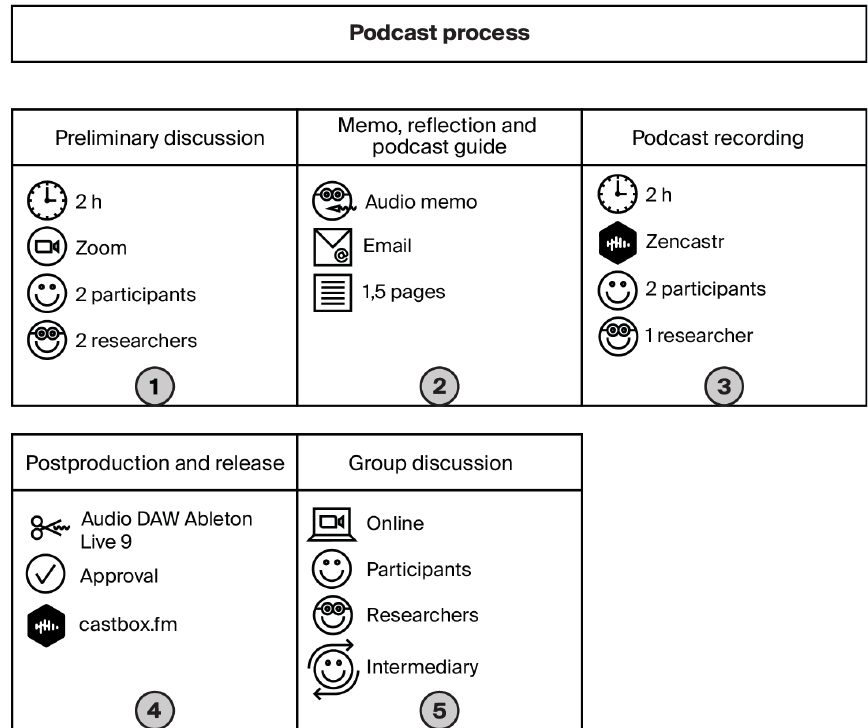
Figure 1. Podcast process. Illustration by Zeynep Keskin. Source: Autor*innen‐Kollektiv INTERPART (2021). Urban Planning, 2022, Volume 7, Issue 3, Pages